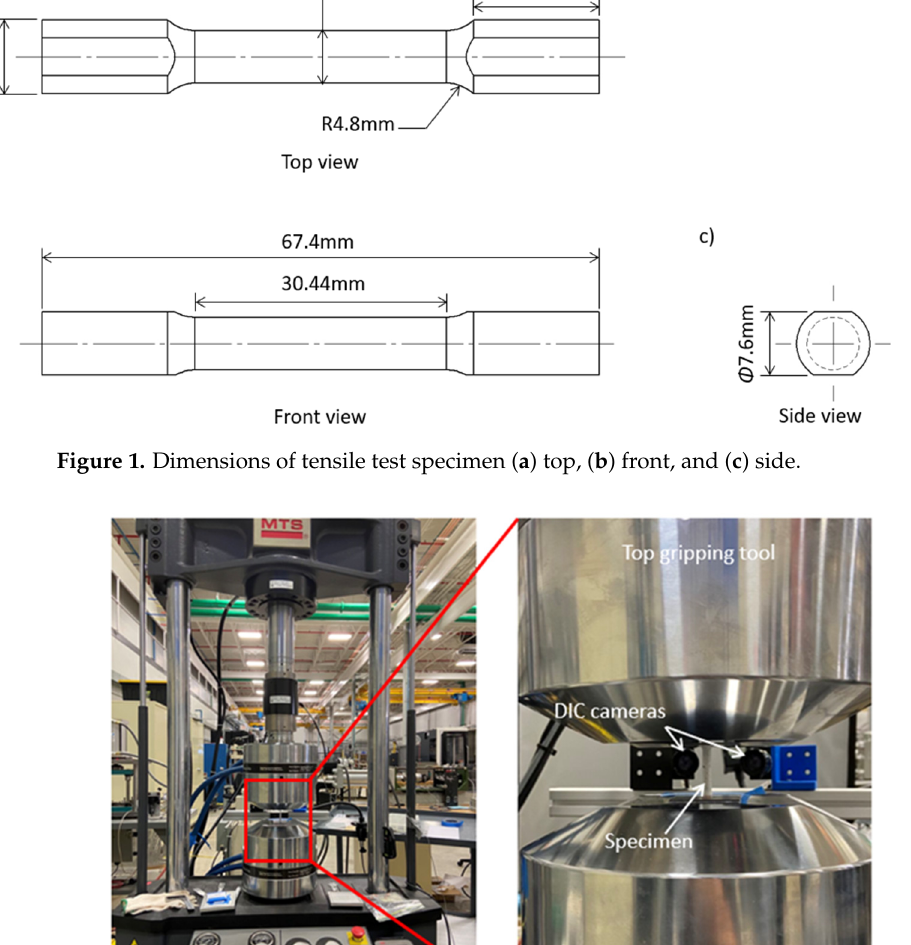
Table 1. Heat treatment information of each material.